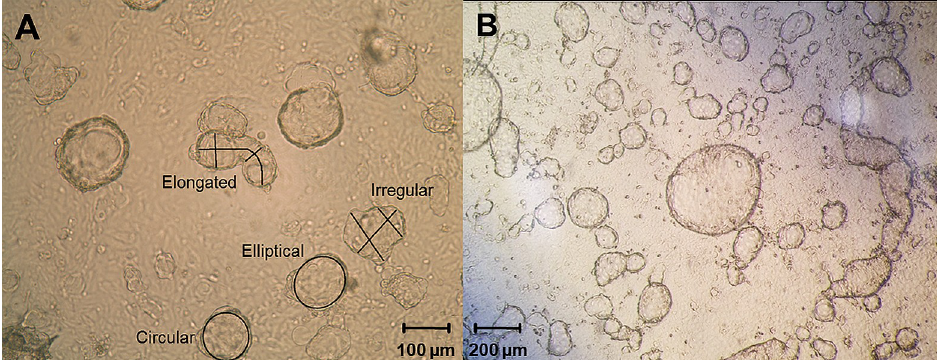
Fig 1. Examples of 3-D endometrial cell structure categories after two weeks of in vitro culture. A) Each shape classification is labeled with its classification by visual inspection. Black lines and circles represent measurements taken using SPOT Advanced Software 3.5.9 with the measurement tools. Photo area: 1.05 mm 2 . B) Lower magnification after two weeks in